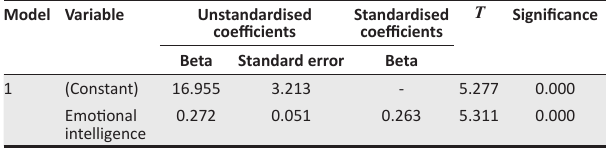
Dependent variable: entrepreneurial intention b , predictors: (constant) emotional intelligence. TABLE 6: Emotional intelligence